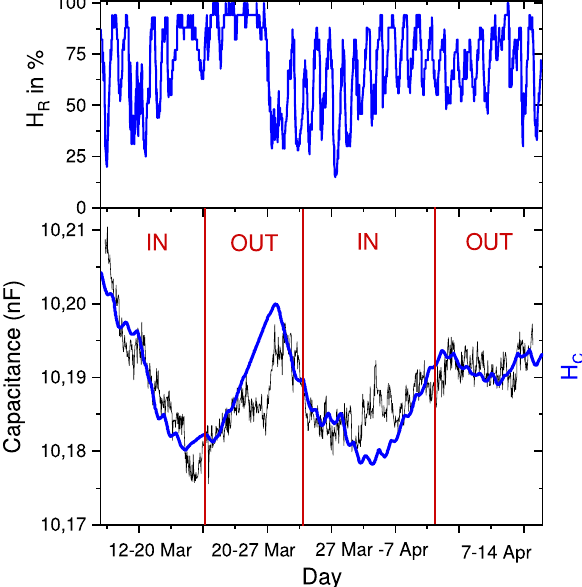
Fig. 9 Relative humidity in the Valencia region (top) in the period 12 Mar–14 Apr 2015 [68]. Plot of the measured capacitance of the detector cable and reference capacitor [27] (thin line) overlaid with the result of a humidity-accumulation model using data from a Valencia weather station [68] (bottom). In the four periods, indicating different placement of the capacitor (inside and outside of the MFC), the model parameters values (cid:3) t = + 16h and ¯ H R = 82%, 73%, 62%, and 72% were used,